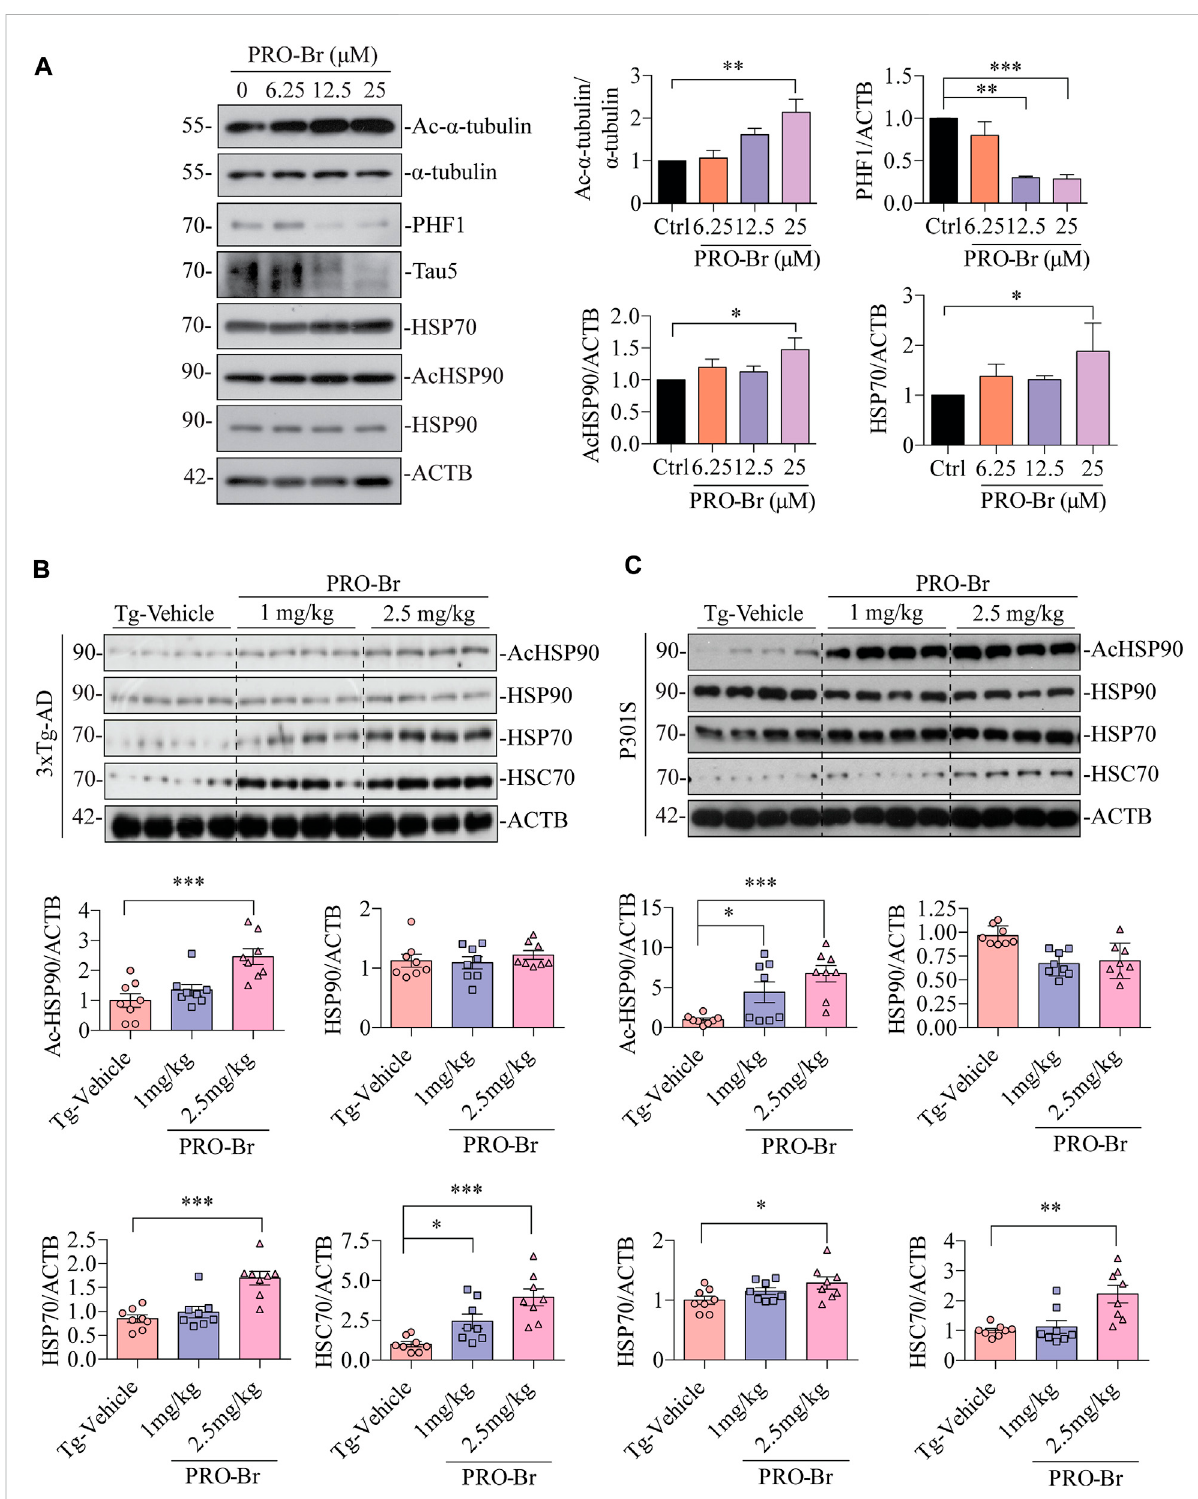
FIGURE 6 PRO-Br enhanced molecular chaperones for the degradation of PHF1. In SHSYP301L cells, (A) PRO-Br dose-dependently increased molecular chaperones. PRO-Br enhances molecule chaperones dose-dependently in (B) 3xTg-AD and (C) P301S mice models. Data was quanti fi ed using ImageJ software, * p < 0.05, ** p < 0.01 and *** p < 0.001 vs. Tg-Vehicle (one-way